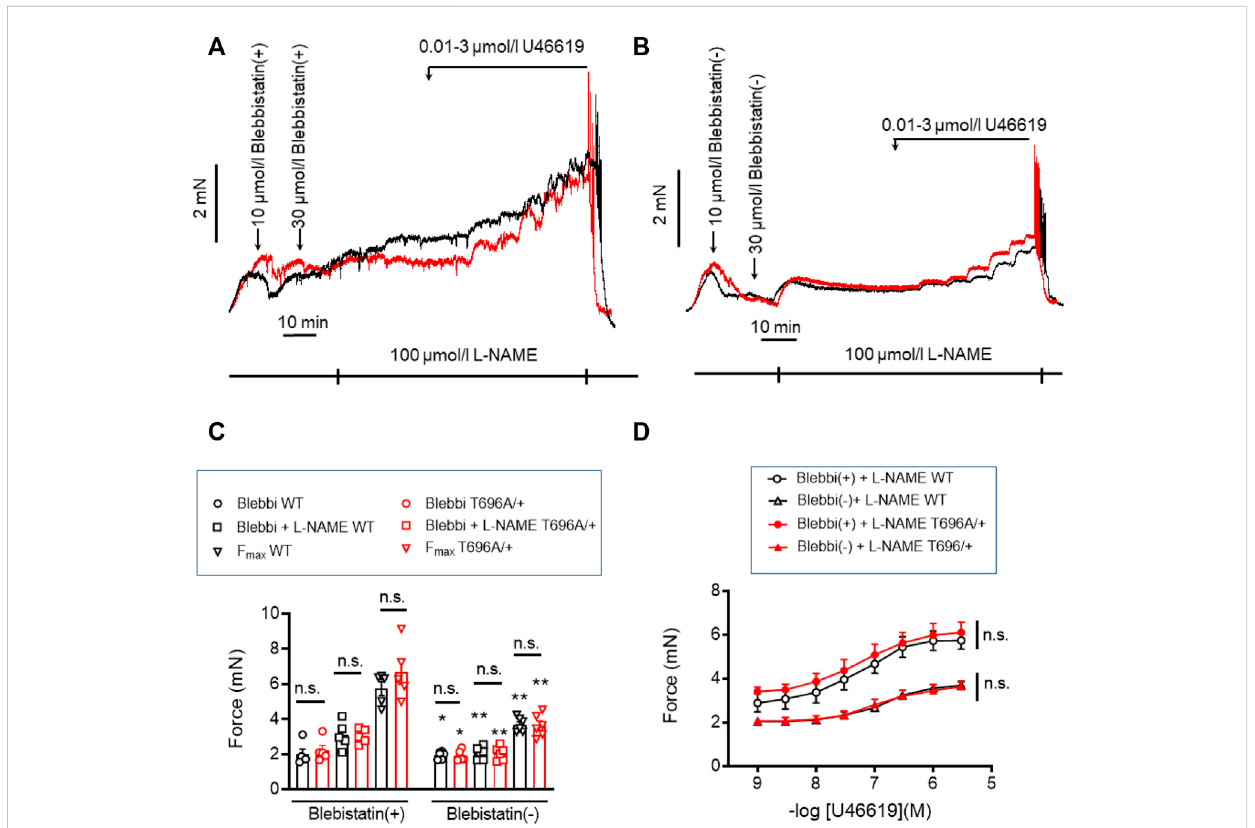
FIGURE 6 Stretch-, L-NAME-, and U46619-induced tone in senescent basilar arteries from WT and MYPT1-T696A/+ -mice under inhibition of cross-bridge cycling of non-muscle myosin. (A,B) Original force tracings representing the effect of the inhibitor of cross-bridge cycling of non-muscle myosin, blebbistatin on tone. Vessels were pretreated with the active ( − ) and inactive (+) enantiomers of blebbistatin and further incubated with 100 μ mol/l L-NAMEandcumulativeapplicationofU46619. (C) Statisticevaluationofstretch-induced,L-NAME-inducedandmaximaltoneinpresenceof(+)or ( − )blebbistatin ( n =5). (D) Statisticevaluationof toneinducedbycumulativeapplication ofU46619 ( n = 5).Data represented as absoluteforce ±SEM;n.s. p > 0.05; two-way ANOVA. * p < 0.05 and ** p < 0.001 calculated by unpaired t